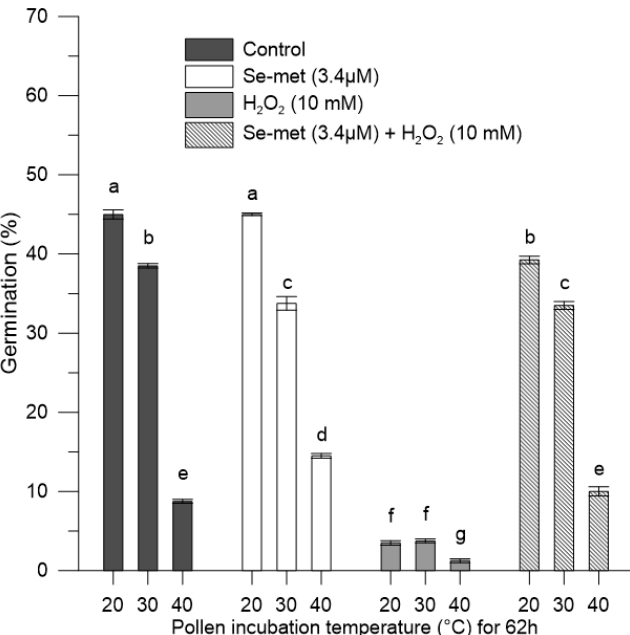
Figure 4. Germination of olive pollen incubated at 20, 30, and 40 °C. Control pollen (control), treated with H 2 O 2 (10 mM), Se-met (3.4 µ M), and Se-met (3.4 µ M) + H 2 O 2 (10 mM). Values are expressed as means ± SEM. Different letters indicate statistically significant differences ( p < 0.05).